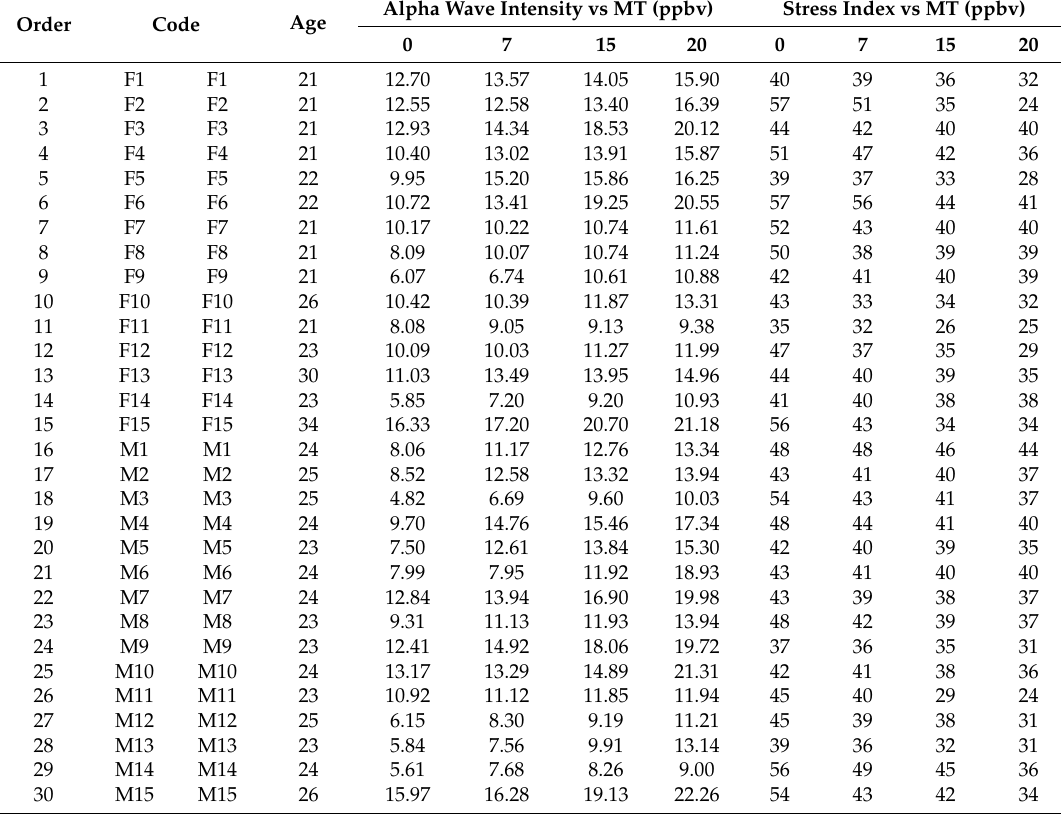
Table A2. Summary of alpha waves and stress index data in the psychological test (Exp 2).